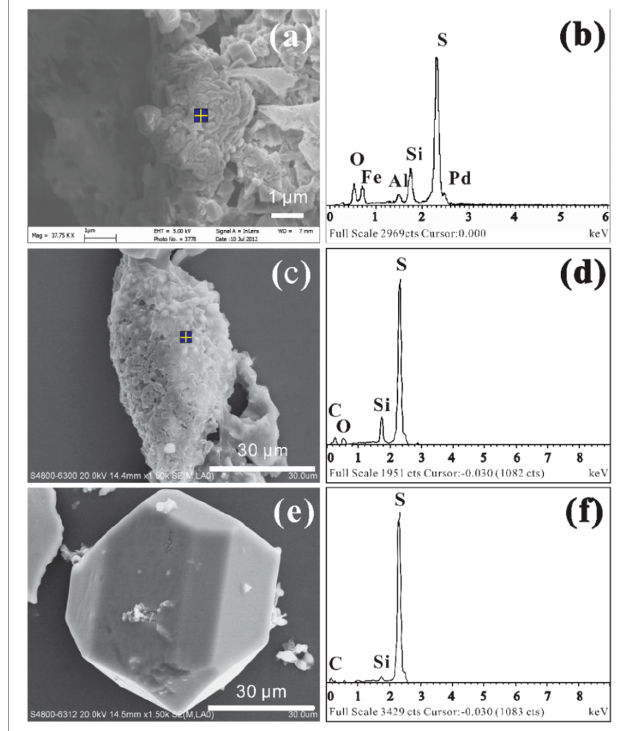
Figure 4. Scanning electron microscope (SEM) images ( a , c , e ) and energy-dispersive X-ray spectroscopy (EDS)-measured chemical composition of element sulfur ( b , d , f ) in different morphologies observed in Kamchatka hot springs. The signal of Pd in the spectrum of ( b ) should be ignored because it was from the instrumental